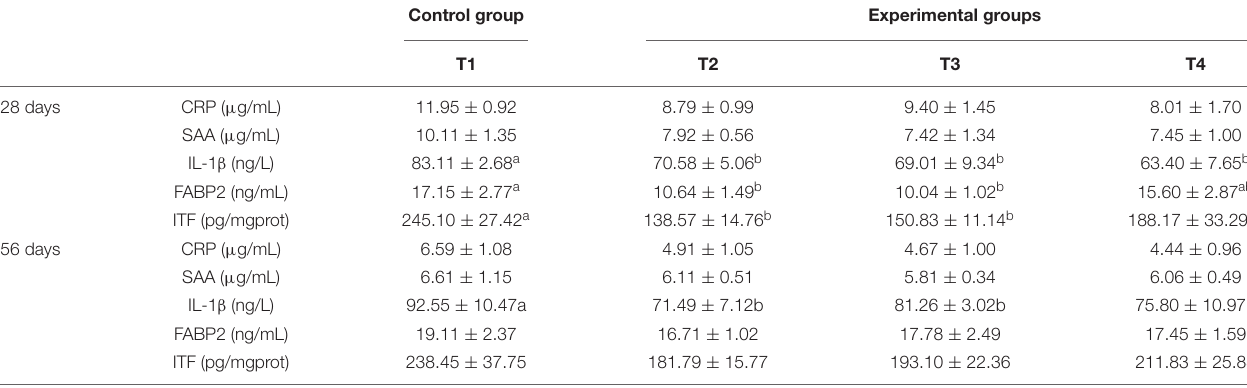
TABLE 5 | Effects of autochthonous probiotics on inflammation markers of grouper ( E. coioides ) fed diets with high levels of histamine.